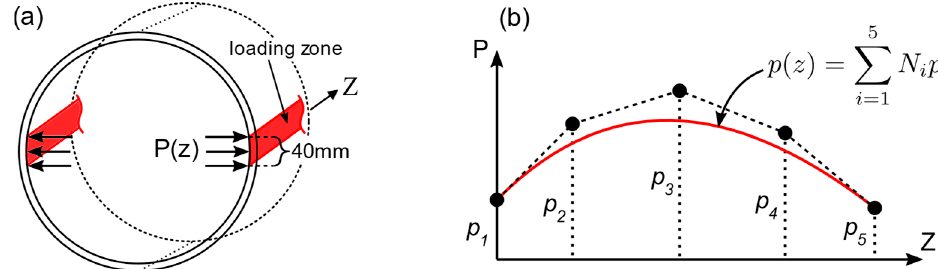
Figure 15. ( a ) Pressure application and loading zone; ( b ) Parametrization of the pressure distribution function along Z-direction; p i are free parameters which influence the shape of p ( z ) In order to fit the fiber strains using optimization, the objective function (cid:1831) was de- fined as the sum of squared errors between observed fiber strains (cid:2013) strains (cid:2013) (cid:3033) at each sampling point along the fiber.